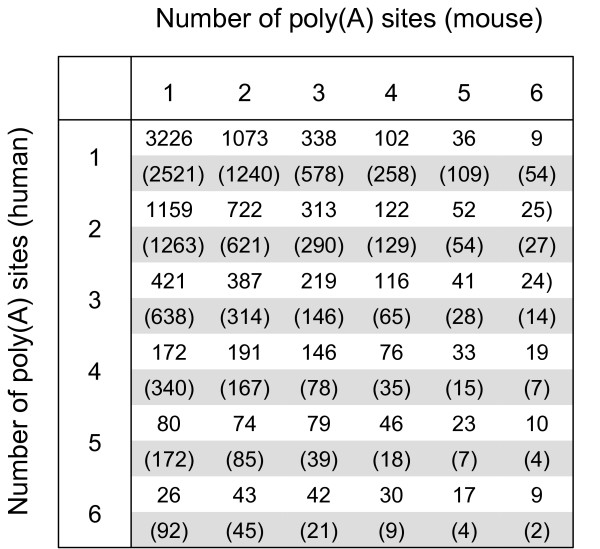
Distribution of ortholog gene pairs against polyadenylation site numbers in human and mouse genes. Table cells provide numbers of orthologous gene pairs in function of the number of polyadenylation sites in human genes (rows) and in mouse genes (columns). Expected values, based on the null hypothesis that there is no correlation, are shown in parentheses. Correlation P value: 6.2 × 10-260 (χ2 test).